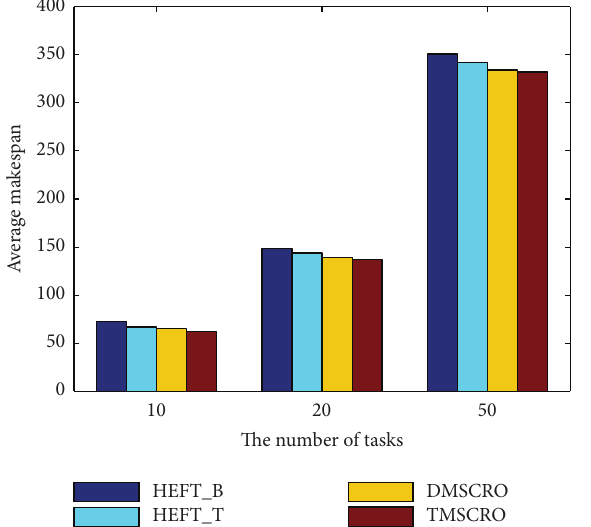
Figure 21: Average makespan of four algorithms under different processor numbers and the low communication costs; the number of tasks is 50.